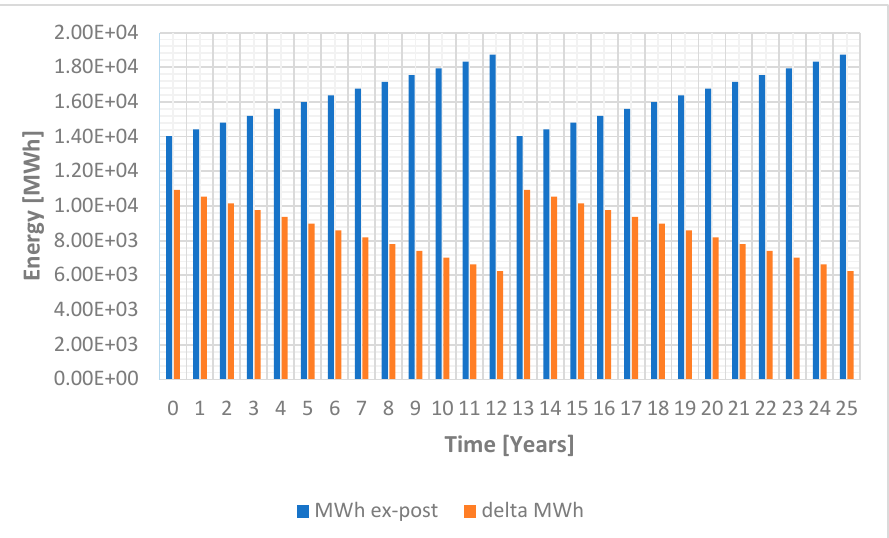
Figure 6. Decrease in energy savings for the WWTP and the electricity consumed after the intervention over the lifespan of the project, considering planned cleaning after 12 years. Based on the available Eurostat data and historical trends from 2008 to 2022, the cost of energy was analyzed using minimum, maximum, mean, and dynamic electricity costs, varying as observed in the period between 2008 and 2022 (Figure 7).